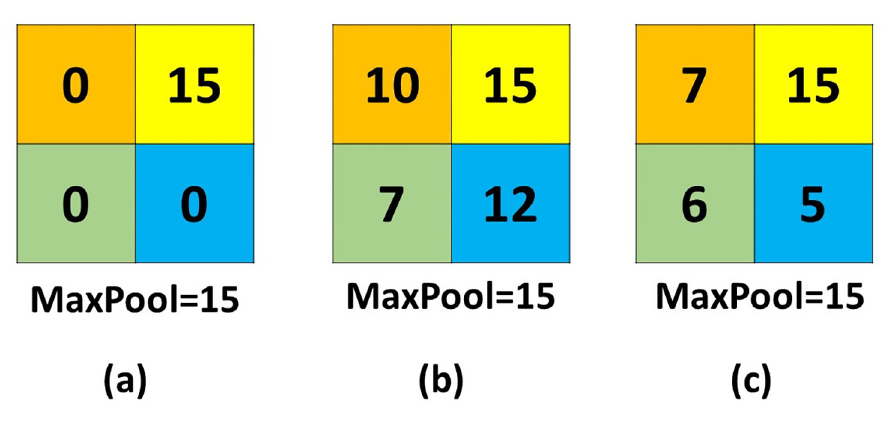
Fig 2. MaxPooling of three different matrices is the